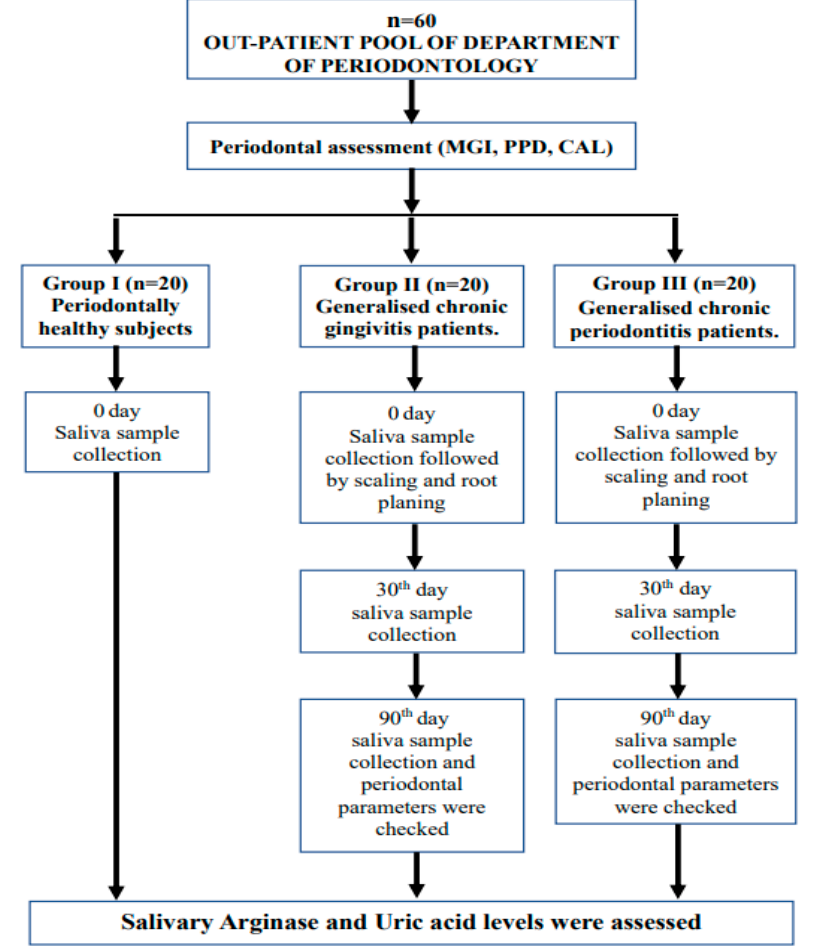
Figure 1. Flowchart of the study Figure 1 . Flowchart of the study design.